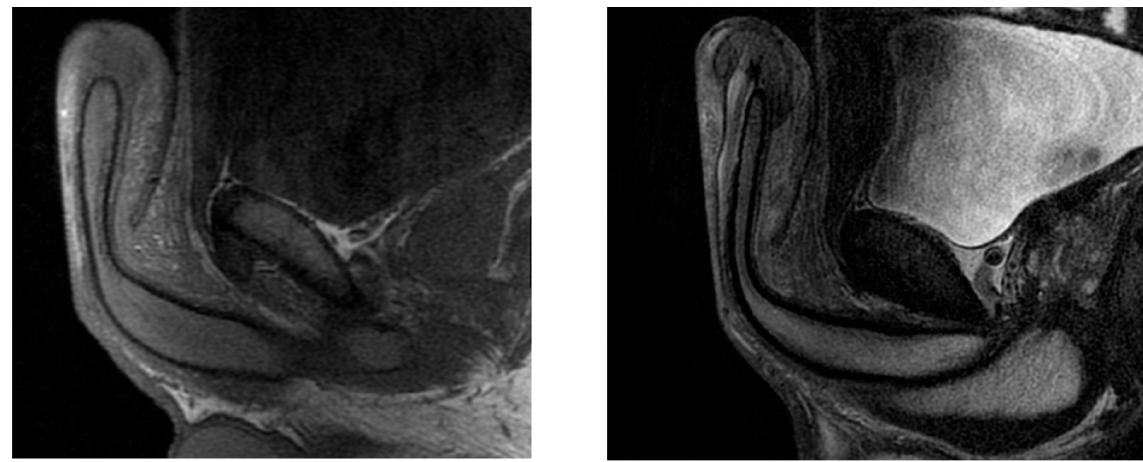
Figure 2. The para ffi noma was heterogeneous in T1 (on the left) and T2 (on the right). Figure 2. The paraffinoma was heterogeneous in T1 (on the left ) and T2 (on the right